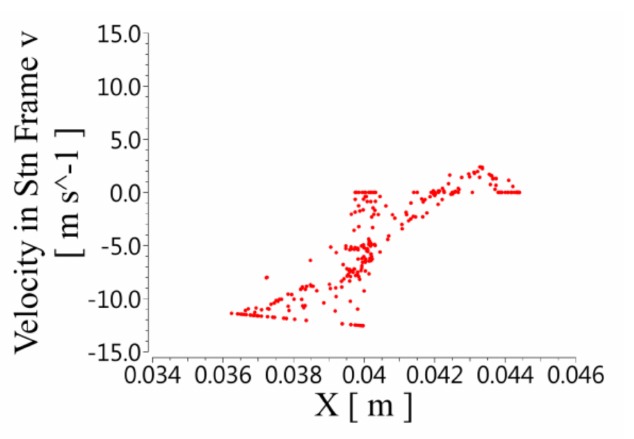
Figure 9. Distribution of circumferential velocity at different X positions on the XY